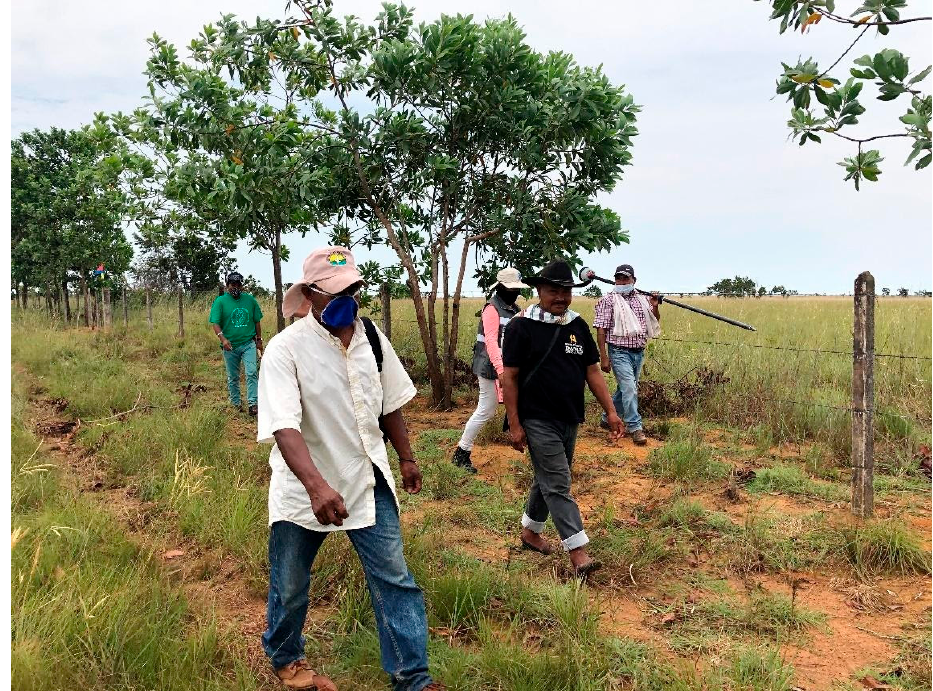
Figure 8. Measuring the boundary of the Muco Mayoragua reserve with one of the Indigenous leaders. Cumaribo, 2020. Source: Land in Peace Project, Kadaster. leaders. Cumaribo, 2020. Source: Land in Peace Project,